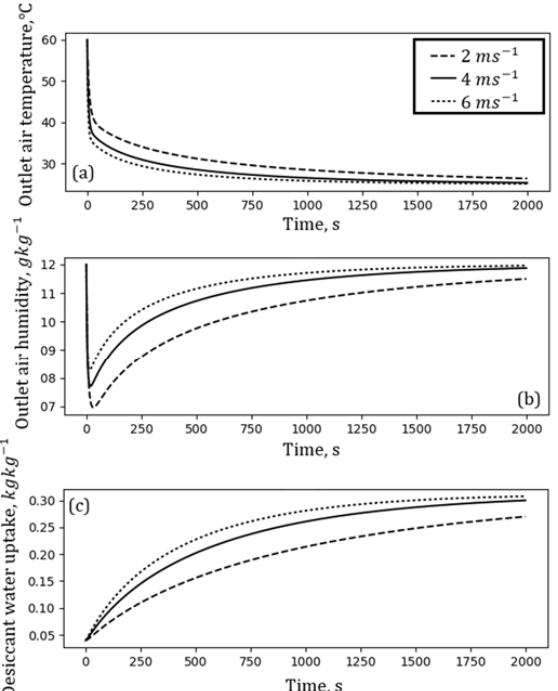
Figure 9. The influence of the superficial air velocity on adsorption characteristics: ( a ) Outlet air temperature; ( b ) Outlet air humidity; ( c ) Desiccant water uptake.